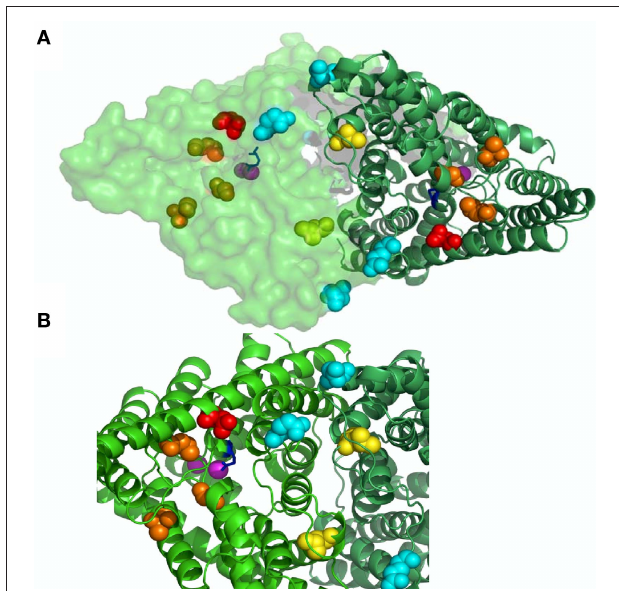
Figure 3 | Binding sites on CLC-K channels. In (A) a view from the outside of the bacterial CLC-ec1 (pdb code 1OTS) homodimer is shown with one subunit in cartoon and the other in surface representation. In (B) a zoom of a selected region highlighting the residues involved in ligand binding. Cl − ions in pink; gating glutamate in blue; N68 implicated in block by CPP in red (D54 in CLC-ec1); H497 mediating H + block in yellow (L421 in CLC-ec1); E261 and D278 forming the Ca binding site in cyan (E235 and N250 in CLC-ec1); L155, G345, and A349 which are important for NFA potentiation in orange (L139, T312, and G316 in CLC-ec1).